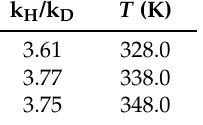
Scheme 2. Table 1. Kinetic Isotope Effect for Isomerization of 1a → 1b at 328 K, 338 K and 348 K. k H /k